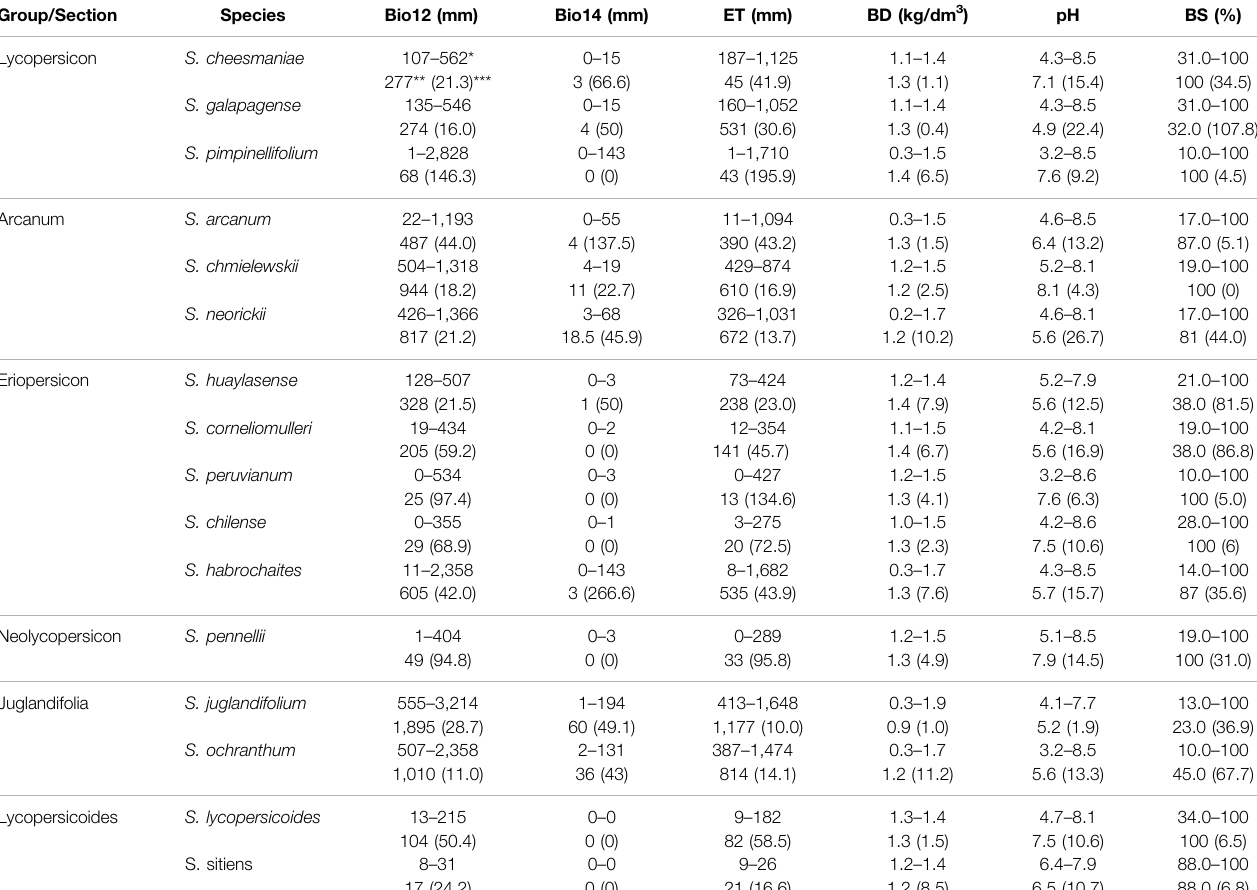
TABLE 3 | Ecological descriptors of climatic and edaphic variables associated with the fi rst canonical correlation (71.4%) for12 species of wild tomato and 4 closely related species. Bio12 (cid:1) annual precipitation, Bio14 (cid:1) precipitation of driest month, pH (cid:1) hydrogen ion concentration. *Range (maximum – minimum value), **median, ***coef fi cient of